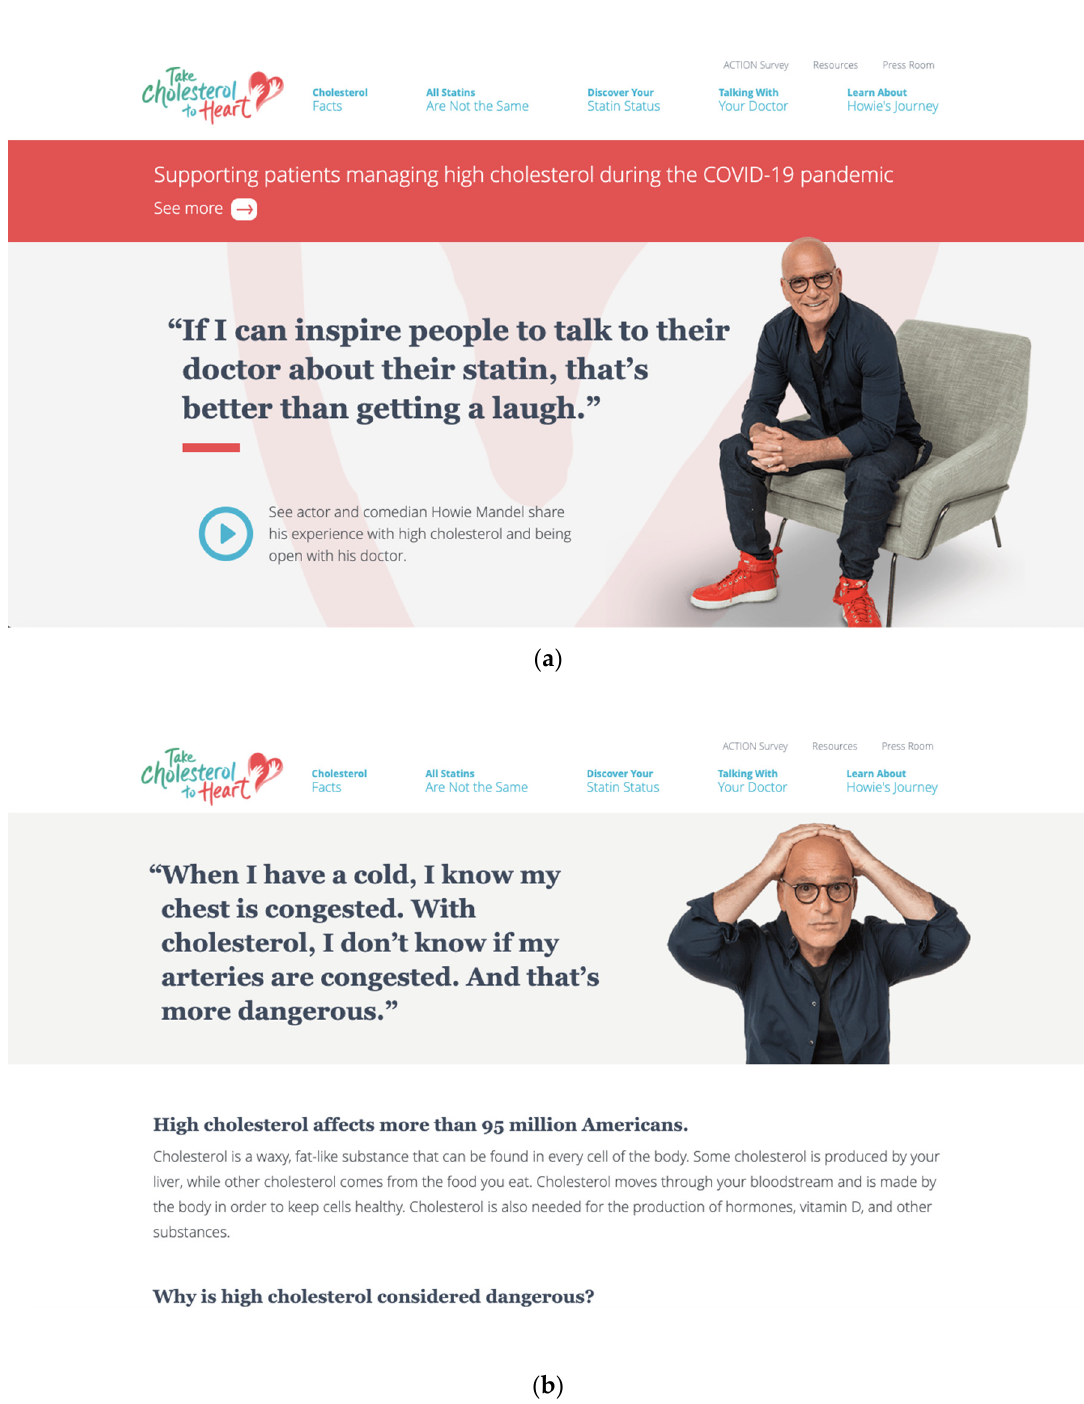
Figure 7. ( a ). Take Cholesterol to Heart website homepage (https://www.takecholesteroltoheart.com/, accessed on 2 November 2021) ( b ). Take Cholesterol to Heart website cholesterol facts page (https://www.takecholesteroltoheart.com/cholesterol-heart-disease, accessed on 2 November 2021).